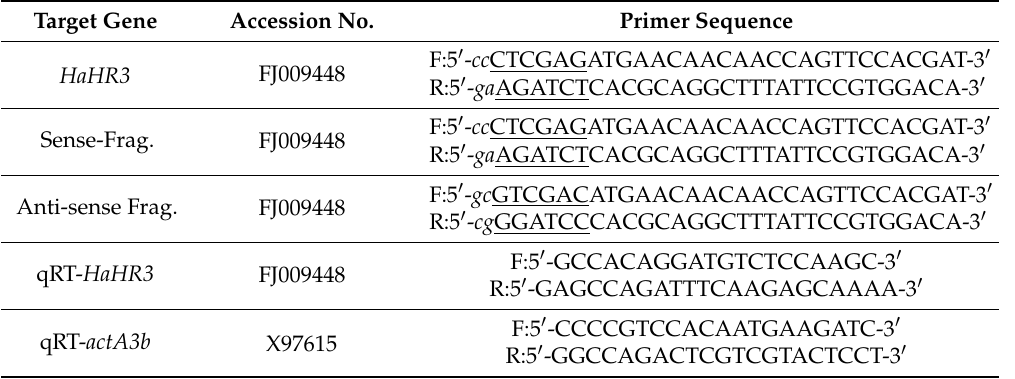
Table 3. Sequences of primers used in this